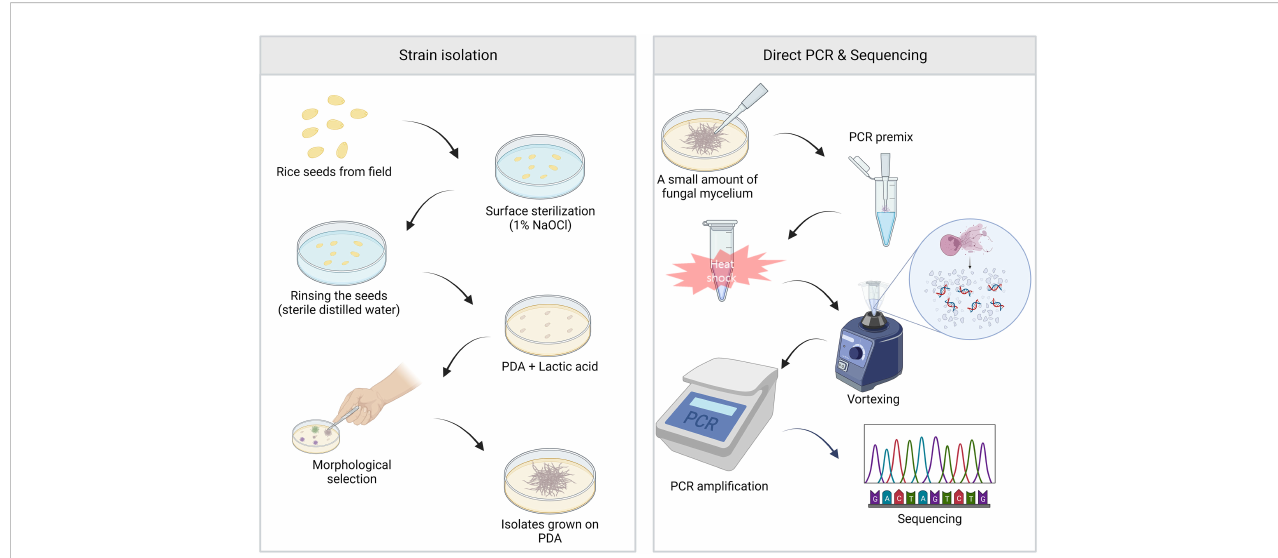
FIGURE 1 The main work fl ow of this study. Left panel, isolation offungal strains. The surface of rice seeds collected from the fi eld was sterilized with 1% of sodium hypochlorite for 3 min, followed by rinsing with sterile distilled water for 3 min. The seeds were placed on potato dextrose agar (PDA) containing lactic acid, and the plate was incubated at 25°C for fi ve days. The candidate strains of FFSC were isolated based on their morphological characters. Right panel, direct PCR and sequencing. A small amount offungal mycelium was added to the PCR premixture using pipette tips. To amplify target regions, modi fi ed PCR processes involving additional heat shock and vortexing steps prior to the thermocycling were carried out, and the ampli fi ed products were